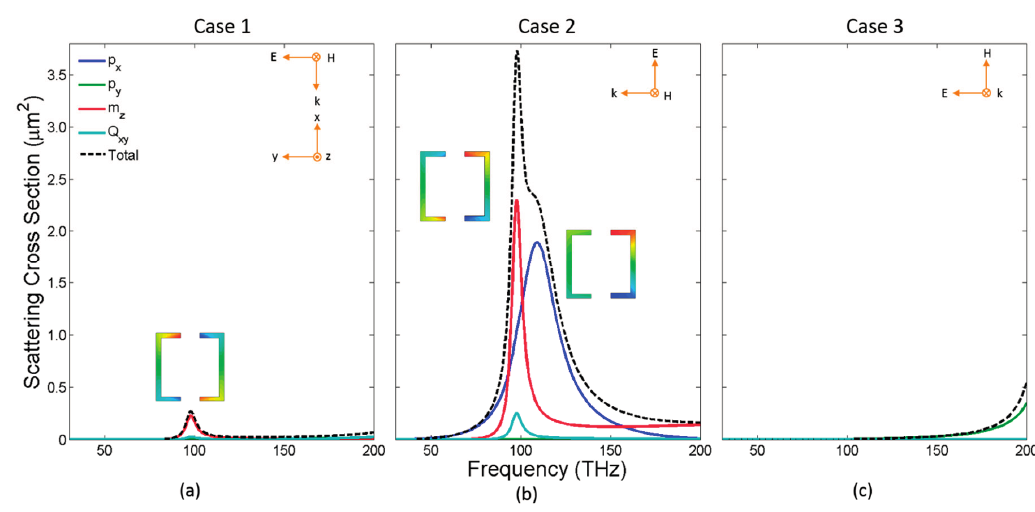
Figure 3. Multipolar decomposition of the scattering cross-section, for a 2-SRR between 30 THz and 200 THz, into the lowest order multipoles; ( a ) Case 1: electric field in-plane and along the gaps, magnetic field out-of-plane; one resonance is observed at f 1 = 98 THz. Weak excitation of electric dipole, (cid:1868) , and the magnetic dipole, (cid:1865) observed. ( b ) Case 2: (cid:3052) (cid:3053) electric field in-plane and normal to the gaps, magnetic field out-of-plane; two resonances are observed, that observed in case 1 plus another one at f 2 = 106 THz. Small overlap between the electric dipole, (cid:1868) , and the magnetic dipole, (cid:1865) observed. ( c ) Case 3: electric (cid:3051) (cid:3053) and magnetic fields in-plane, along the gaps and normal to them, respectively; no at the corresponding resonance resonances are observed. Insets show the real part of (cid:1831) (cid:3053) frequencies using a rainbow colormap (min in blue, zero in green, and max in red). In Figure 5, we plot the scattering cross-sections of the 4-SRR (even) for the three cases defined in Figure 1. For this case, case 1 and case 2 are identical due to the symmetry of the 4-SRR and are referred to from here on as case 2. In case 2, only modes that are even with respect to the (cid:1876)(cid:1877) -plane and odd with respect to the (cid:1877)(cid:1878) -plane can be excited. In case 3, only modes that are even with respect to the (cid:1877)(cid:1878) -plane and odd with respect to the (cid:1876)(cid:1878) -plane can be excited. Due to these symmetry constraints, the , cannot be excited in case 3, the electric dipole, (cid:1868) , cannot be excited in case 2, the electric dipole, (cid:1868) (cid:3051) (cid:3052) magnetic dipole, (cid:1865) , and the electric quadrupole, (cid:1843) , cannot be excited in case 3. As a result, there (cid:3053) (cid:3051)(cid:3052) can only be an overlap between the electric dipole, (cid:1868) , and the magnetic dipole, (cid:1865) , in case 2. (cid:3051) (cid:3053) However, as can be seen from Figure 5, only the magnetic dipole, (cid:1865) , is strongly excited in this case (cid:3053) (f 1 =203 THz). For the 4-SRR, there is thus no preferred illumination